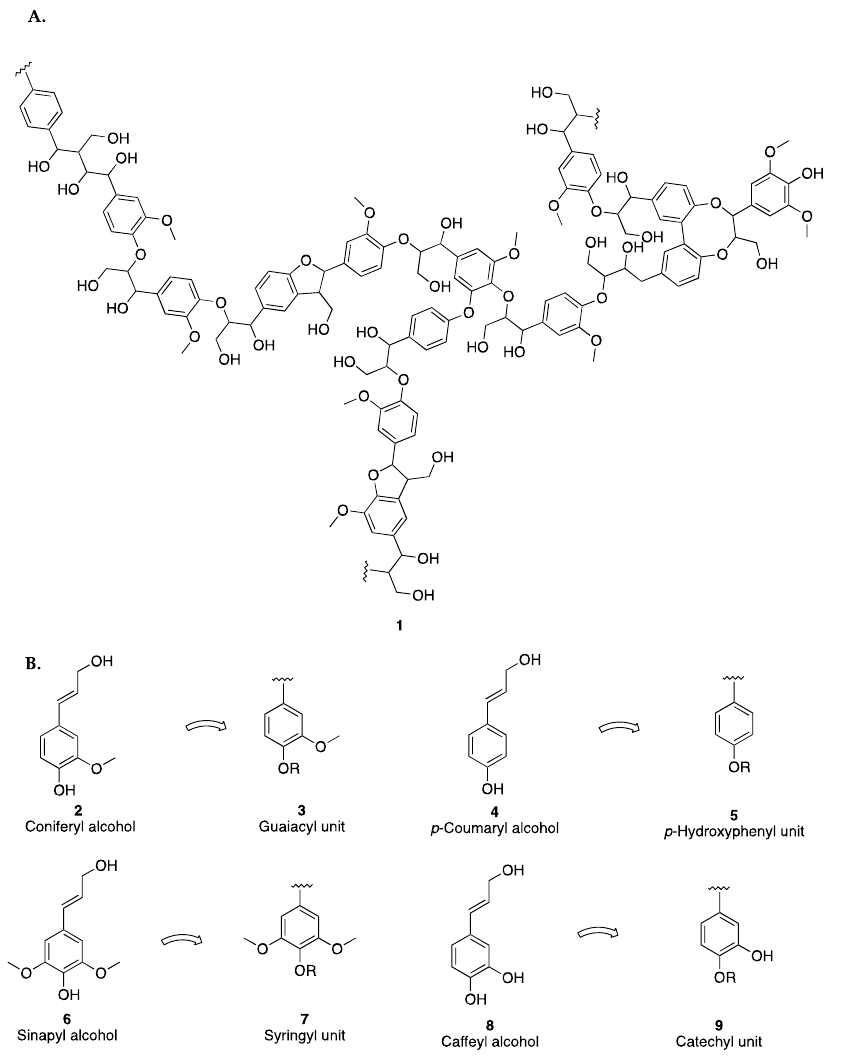
Figure 1. ( A ) Lignin structure; ( B ) monomers and